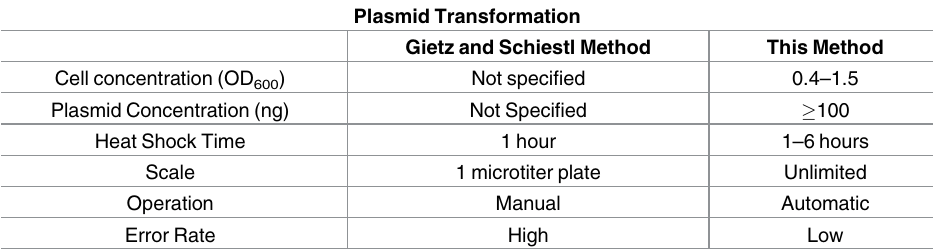
Table 4. Comparison of the two plasmid transformation methods.